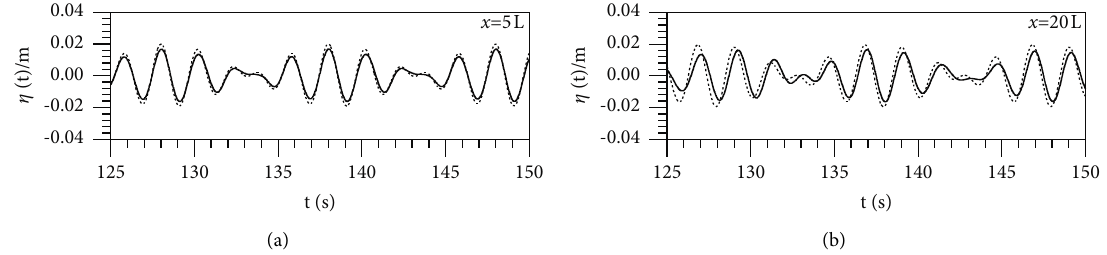
Figure 6: Comparisons of the wave profiles between the calculation results (solid line) and theoretical results (dashed line) at different gauge locations for case D1.